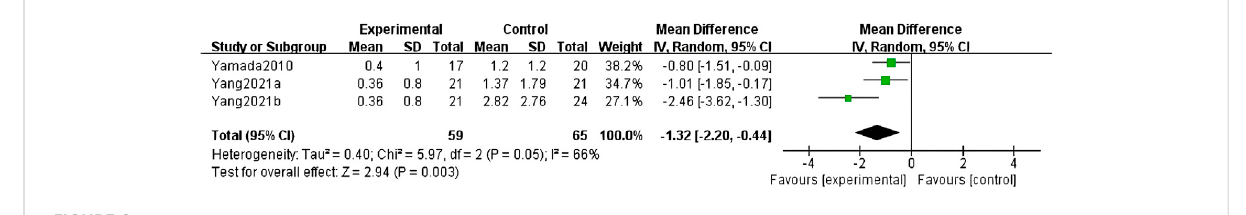
FIGURE 2 Forest plot of the relapse rate of Behçet ’ s uveitis in the anti-TNF- α - and traditional immunosuppressant-treated